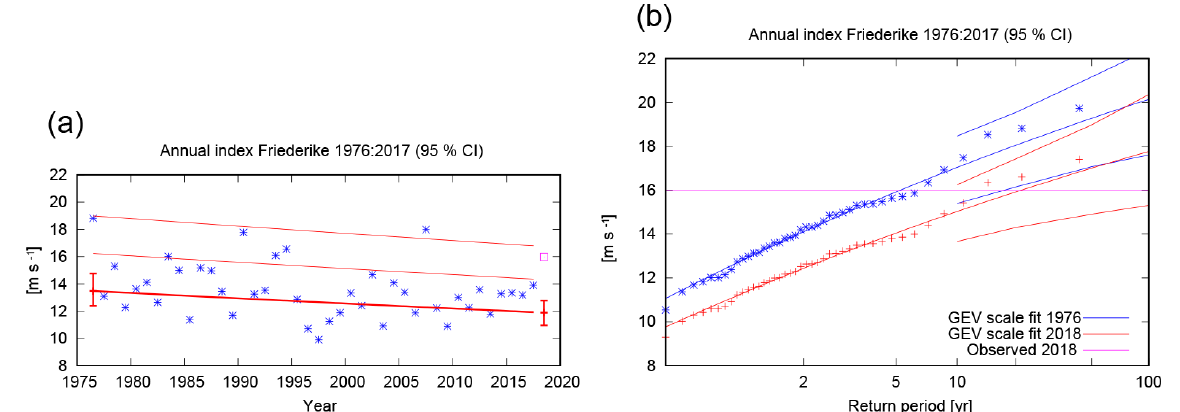
Figure 4. (a) Highest winter value of the Friederike index described in Sect. 2 fitted to a generalized extreme value (GEV) function that scales with time. The thick line denotes the position parameter µ , the thin lines the 1 in 6 years and 1 in 40 years return values. (b) The GEV fit as a function of return period for the climate of 1976 (blue, observations have been scaled up with the fitted trend) and 2018